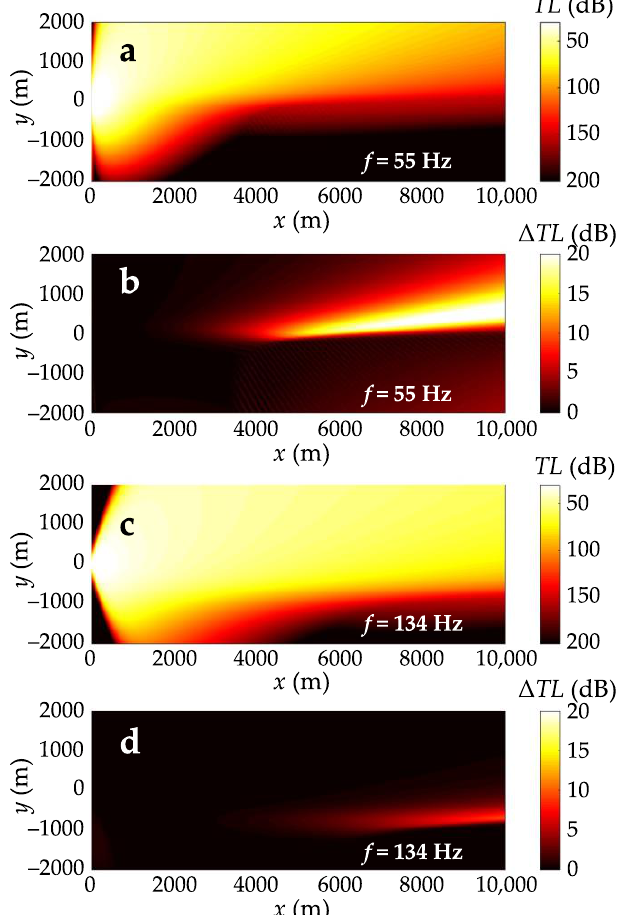
Figure 4. Contours in dB of the depth-averaged transmission loss TL in the horizontal plane at ( a ) 55 and ( c ) 134 Hz; the difference between transmission loss ∆ TL obtained by mode parabolic equation solution and N × 2-D approximate solution at ( b ) 55 and ( d ) 134 Hz.